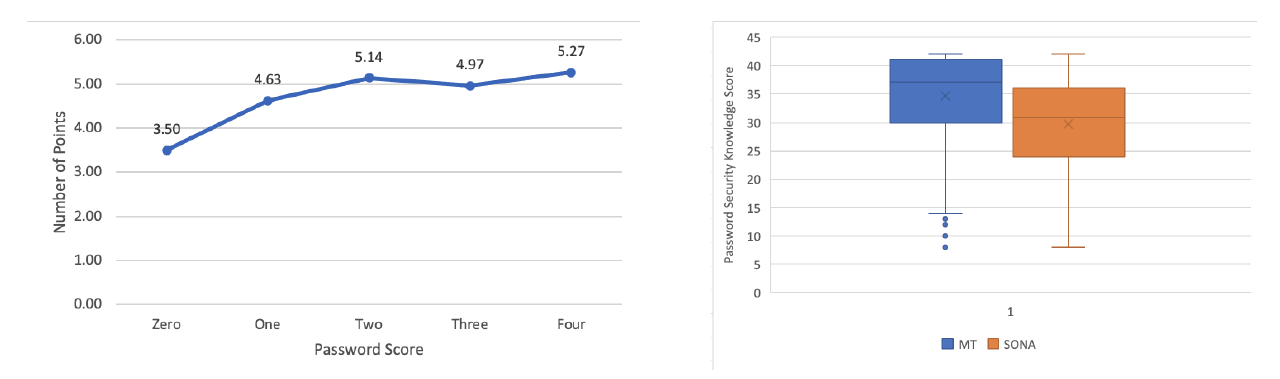
Figure 11. SONA survey: Responses about password security in relation to zxcvbn password scores.